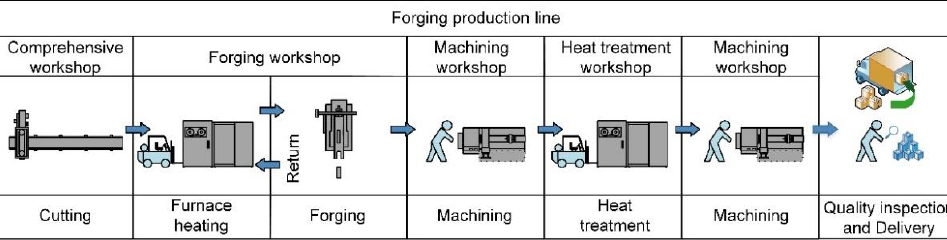
Figure 2. Forging production process.